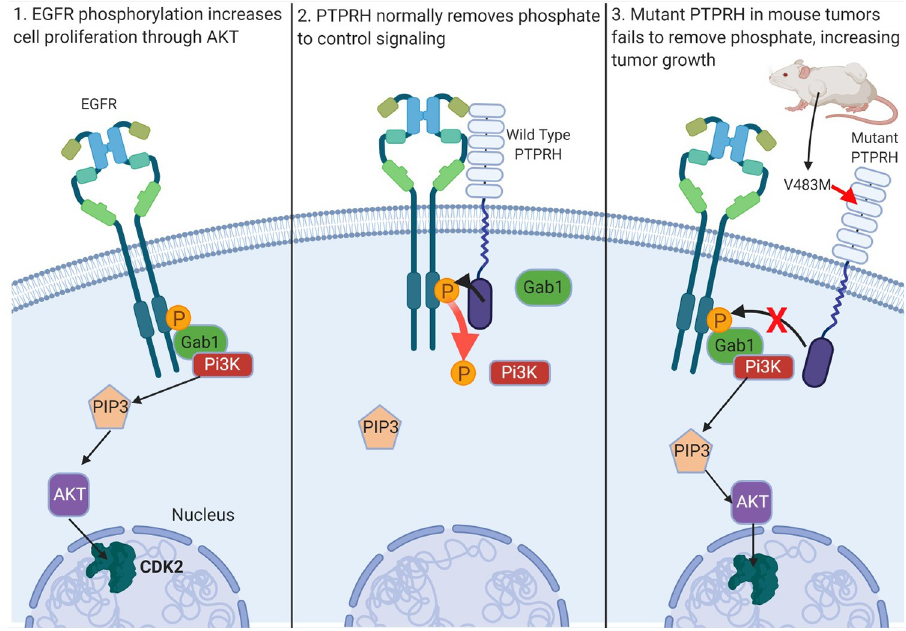
Fig 7. Schematic of Ptprh mutant mouse tumors failing to dephosphorylate EGFR. Ordinarily, PTPRH is responsible for regulating EGFR signaling through dephosphorylation of tyrosine residues on the C-terminal tail of EGFR. We have shown PTPRH mutant mouse tumors and PTPRH KO human cells to have increased phosphorylation of EGFR, and subsequent increased activation of the PI3K/AKT pathway.